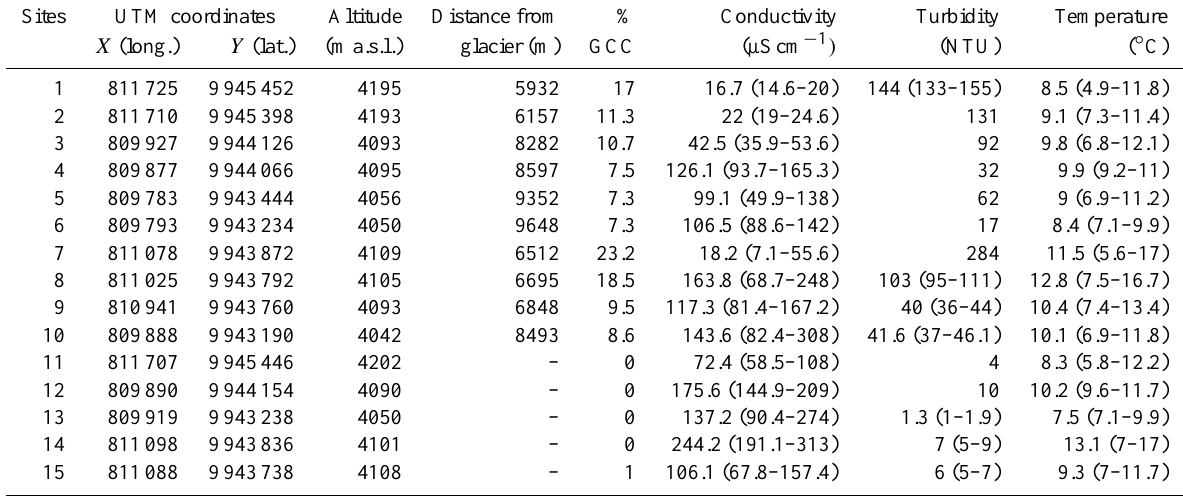
Table 1. Physico-chemical attributes of the study stream sites (see location of the sites on Fig. 1). Conductivity, turbidity, and temperature are means with min-max values given in brackets ( n = 2 to 10 for conductivity and temperatures; n =1 to 3 for turbidity). Stream sites no. 11 to 15 have no visible connection to the glacier. GCC = glacier cover in the catchment. UTM coordinates refer to stream site coordinates in UTM-WGS84 zone 17S expressed in